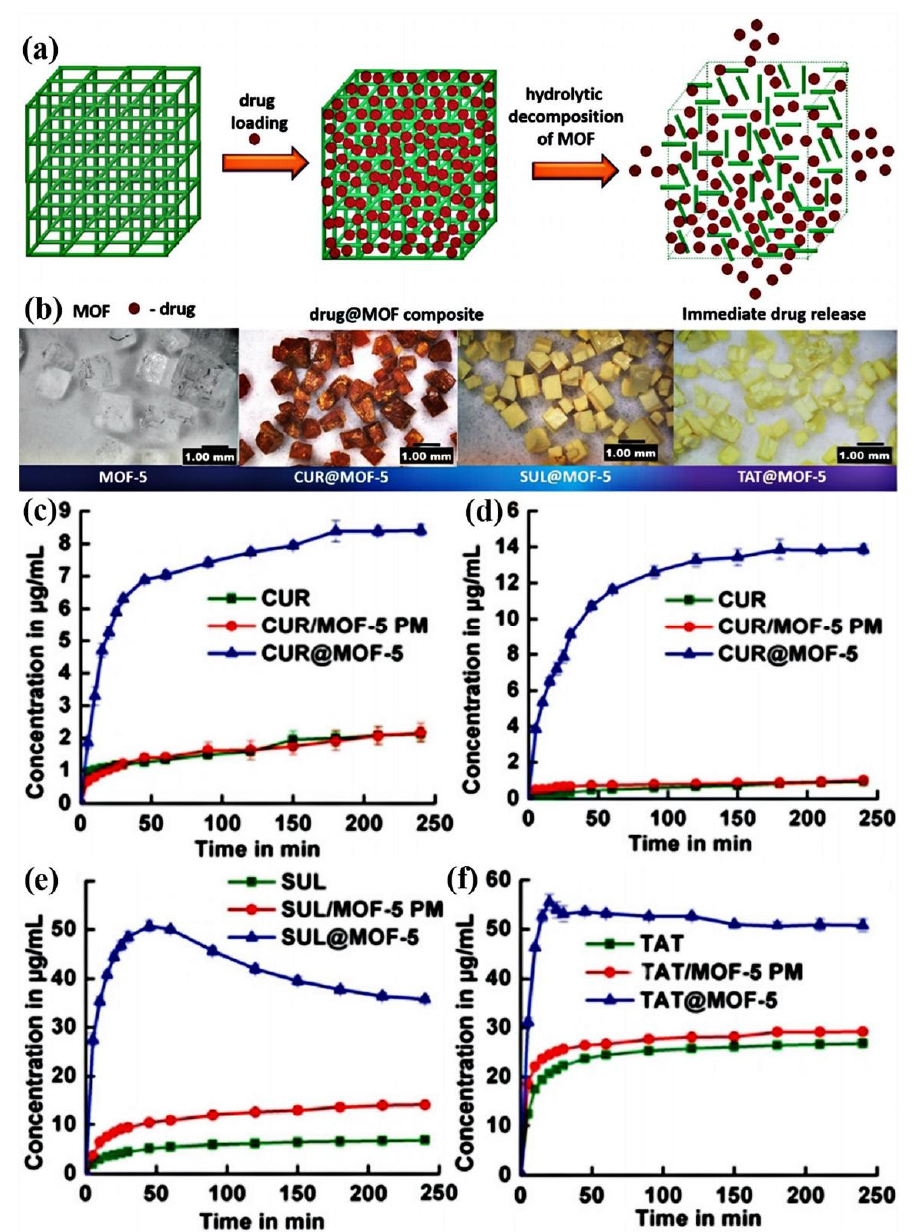
Figure 12. ( a ) The formation of drug@MOF and drug release. ( b ) Optical images of MOF-5 and drug@MOF-5. Dissolution profiles: CUR, CUR@MOF-5, and CUR/MOF-5 PM in ( c ) SG and ( d ) PBS; ( e ) SUL, SUL@MOF-5, and SUL/MOF-5 PM in SG; ( f ) TAT, TAT@MOF-5, and TAT/MOF-5 PM in PBS. Reproduced with permission from Ref. [84], copyright (2019) Wiley-VCH.